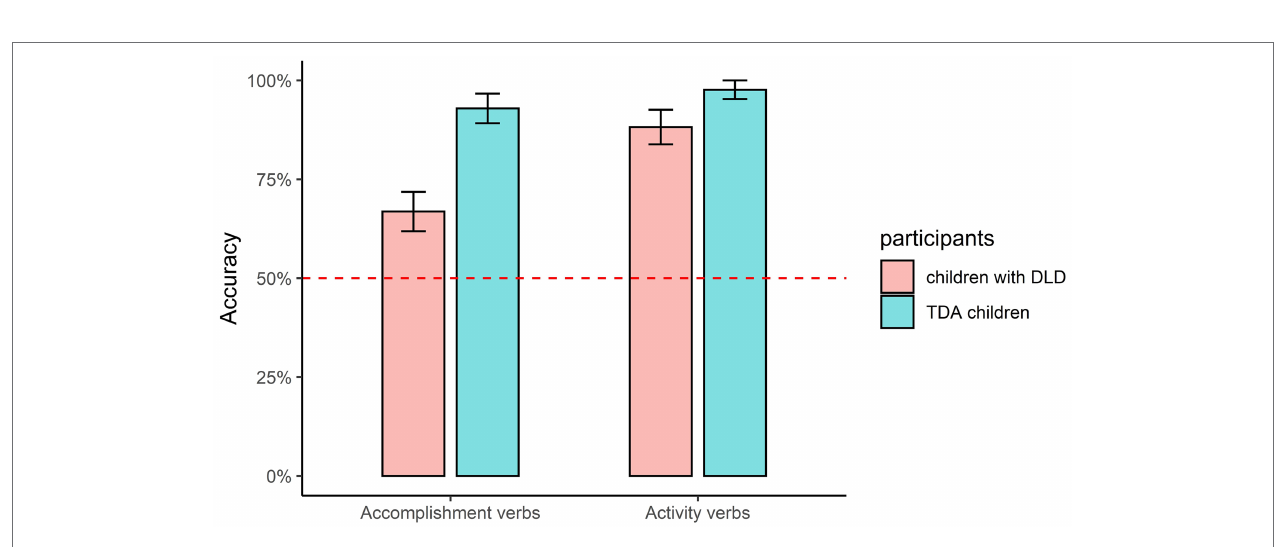
FIGURE 3 | Accuracy of zai - being combined with different types of verbs.